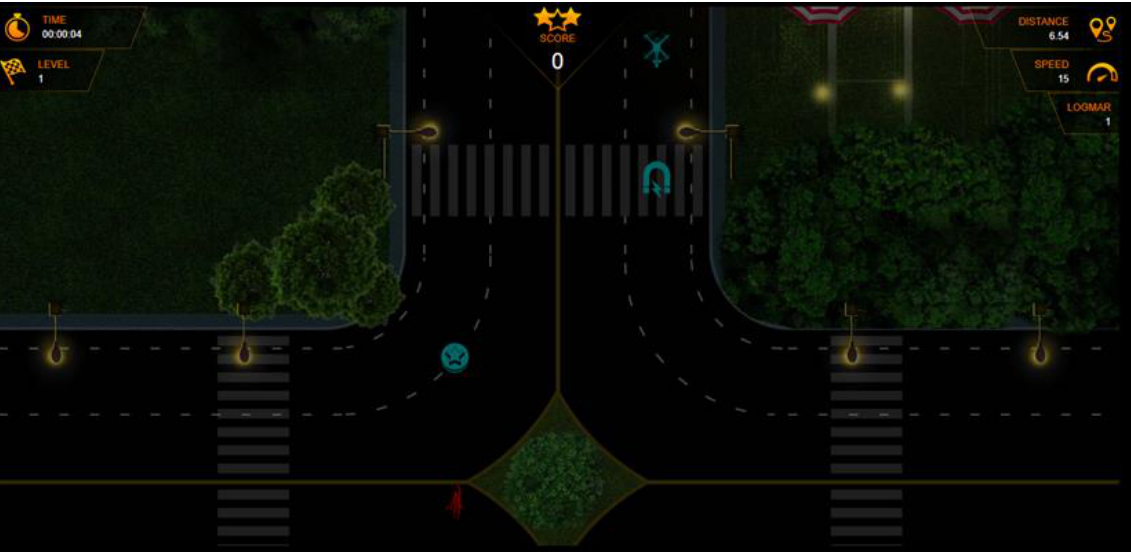
Figure 1. Example of a dichoptic environment used by the platform evaluated that is seen through red-green glasses (only one eye sees the red superman and the other one the rest of the elements).